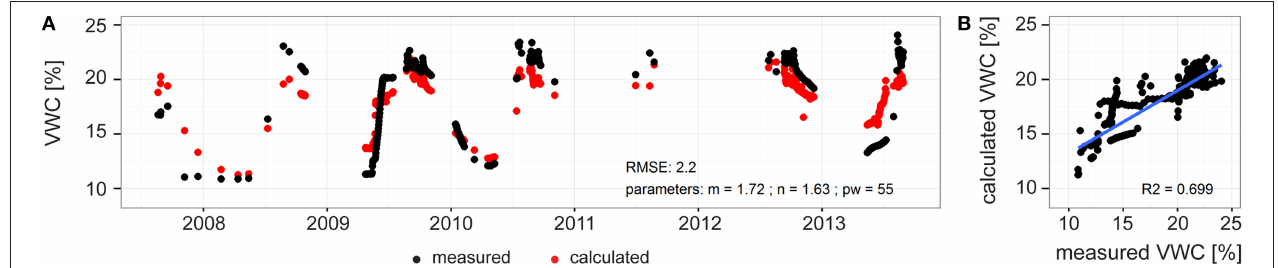
FIGURE 4 | Calibration of the A-ERT-derived VWC using Archie’s law (red) compared to the measured VWC (black) at Schilthorn (A), and the performance of the calibration (B). The blue line represents the linear regression between calculated (Archie) and measured (FDR) data.